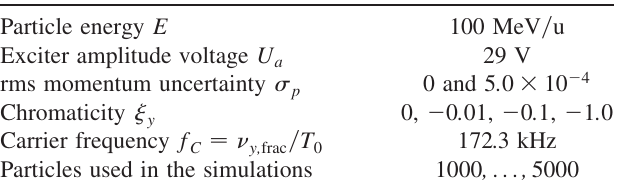
TABLE II. Conditions used in the test tracking calculations presented in this section.